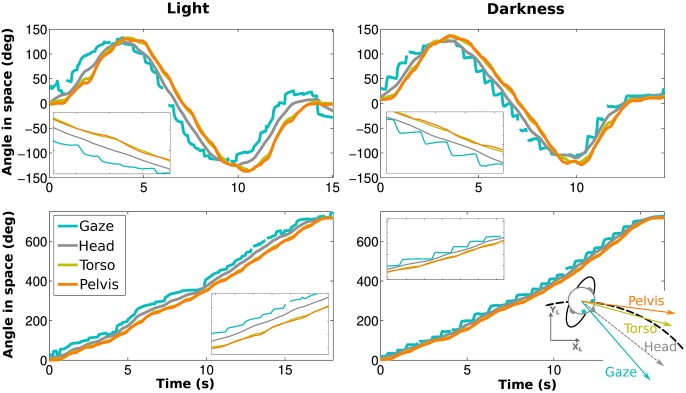
Angle of gaze (blue), head (gray), torso (yellow) and pelvis (orange) while walking on an elongated eight shape (top) and a limaçon (bottom) for the same participant. The left and right figures correspond to light and darkness conditions, respectively. Blowups (X5) are shown as well.